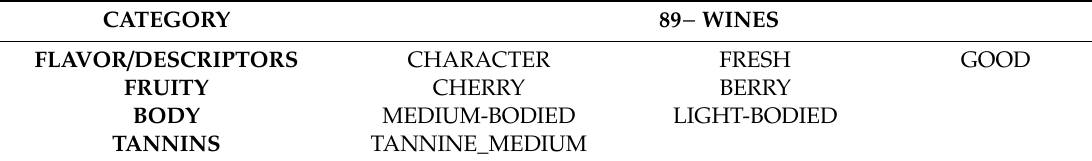
Table 5. Distinct keywords between 90 + and 89 − wines from ALL Bordeaux Wine dataset in 89 − wines.